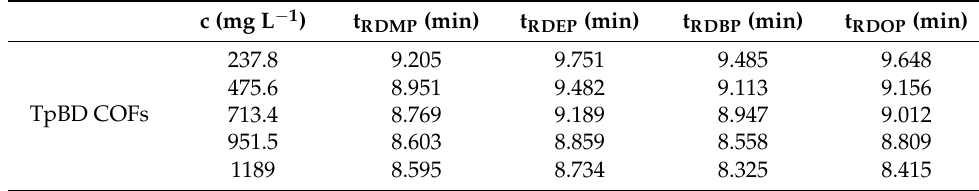
Figure 2. Adsorption curve of PAEs. Table 1. Retention time of material to